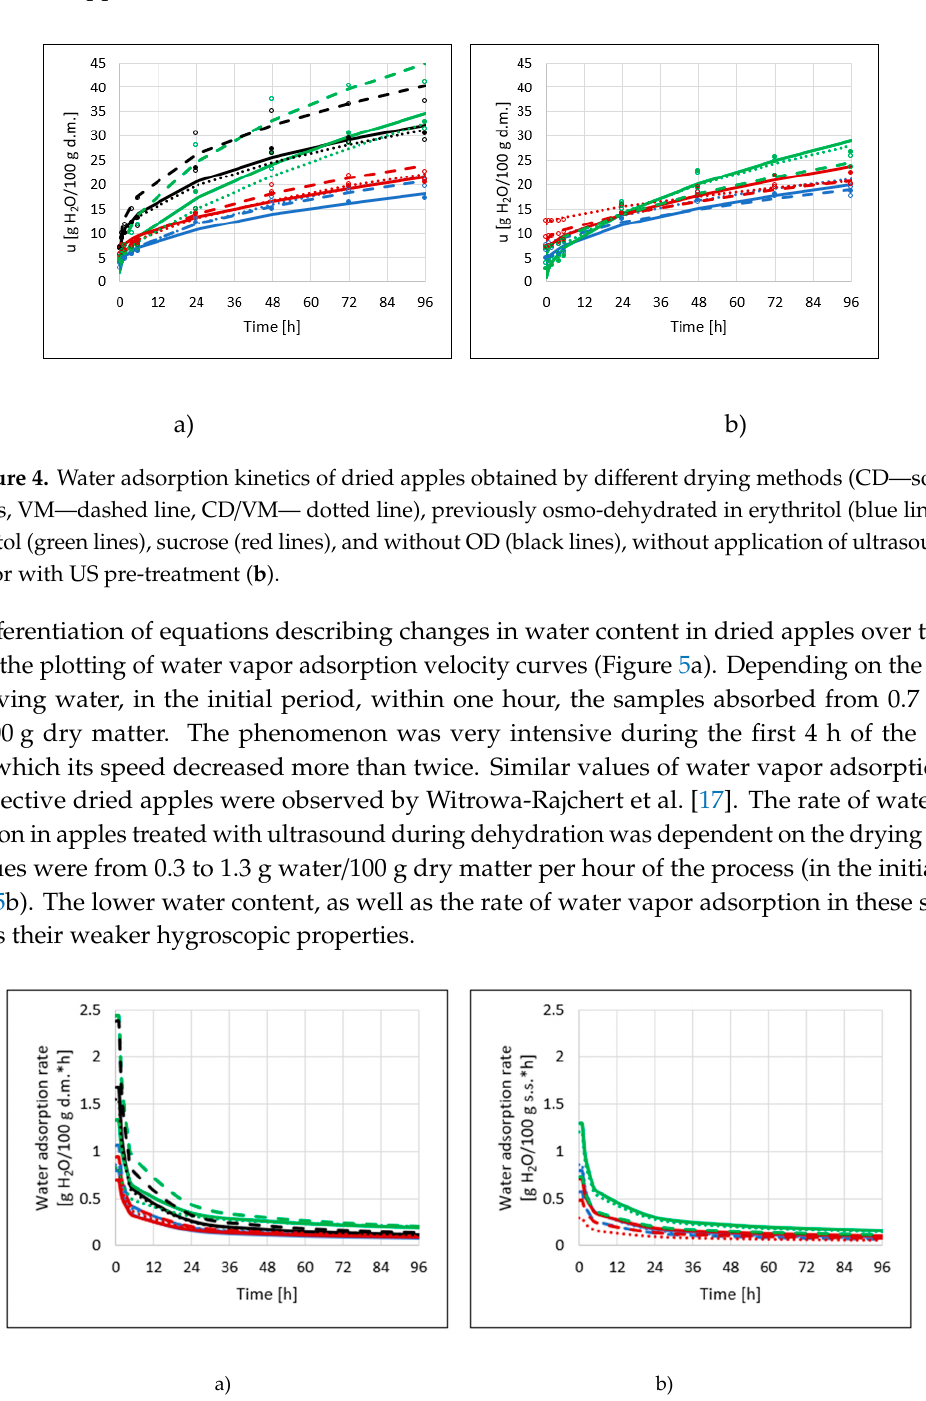
Figure 5. Water adsorption rate of dried apples obtained by different drying methods (CD—solid lines, VM—dashed line, CD/VM—dotted line), previously osmo-dehydrated in erythritol (blue lines), xylitol (green lines), sucrose (red lines), and without OD (black lines), without application of ultrasound ( a ) or with US pre-treatment ( b ). 2.4. Color Changes